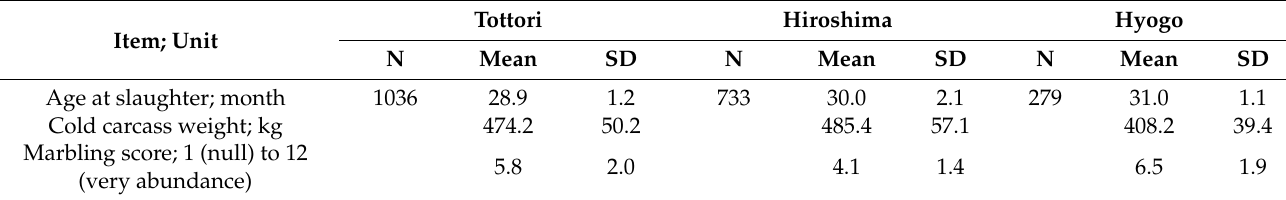
Table 1. Number of records (N) and means and standard deviations (SDs) of phenotypic